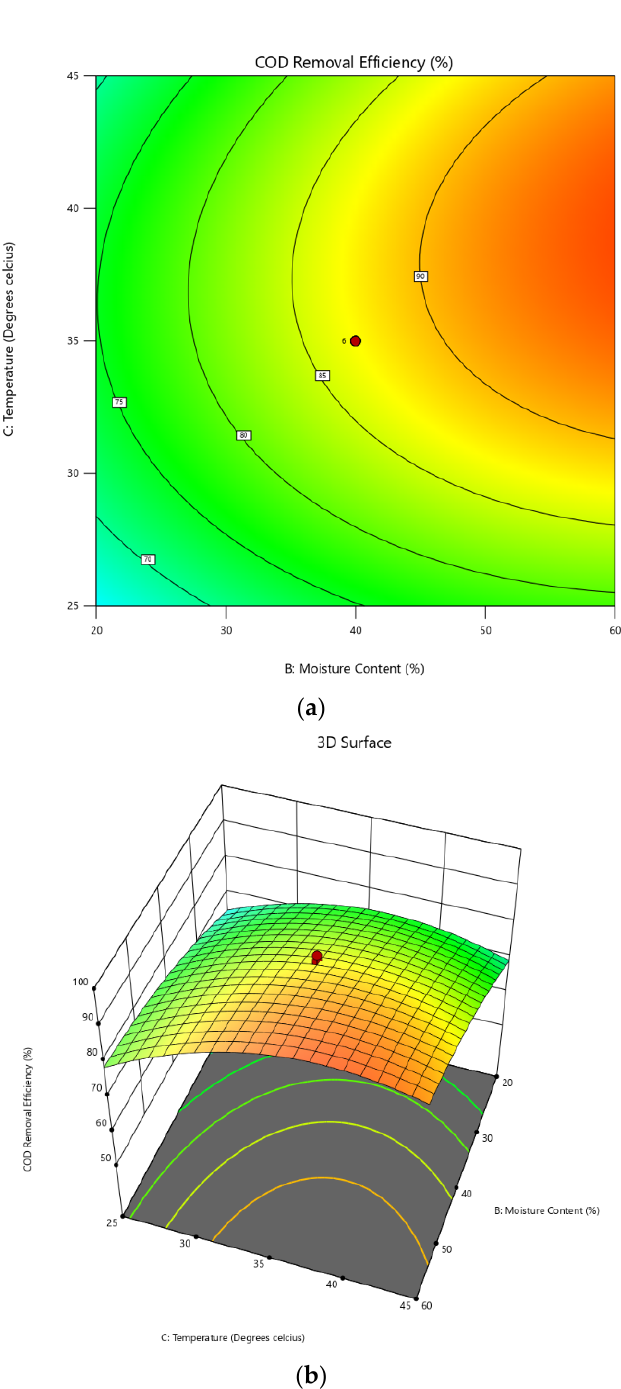
Figure 8. ( a ) Contour plot and ( b ) response surface plot of COD removal efficiency as a function of temperature relative to moisture content.